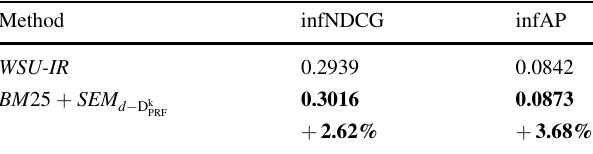
Table 7 Comparison to WSU-IR , the best automatic run in the TREC 2015 CDS task